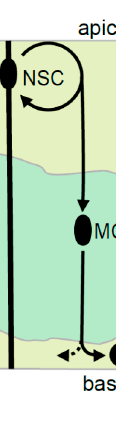
Figure 1. A diagram showing the spatial organization and linear relationships between the neural precursor cell types and the neurons of the mid gestation (E12.5–E15.5) embryonic olfactory epithelium. Abbreviations: NSC—neural stem cell, MC—migrating cell, IPC—intermediate precursor